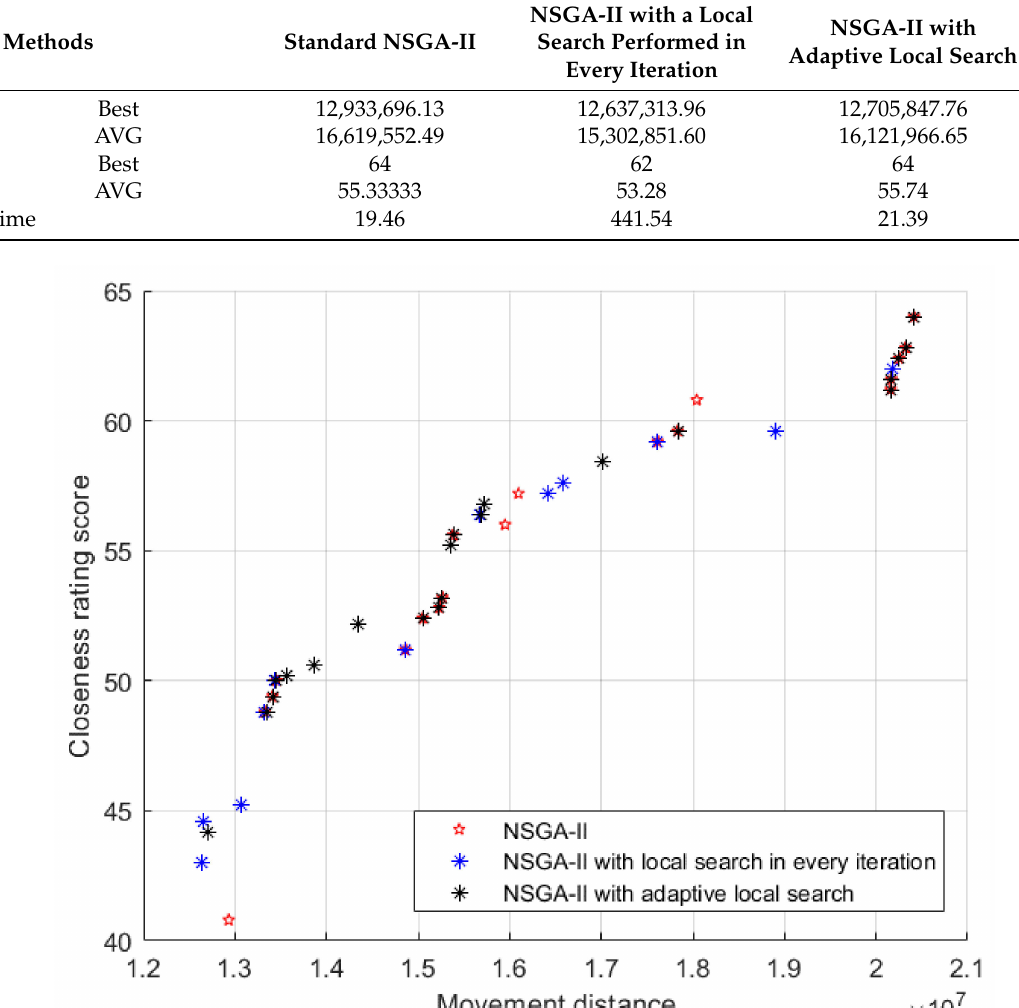
Table 10. Comparison of results.